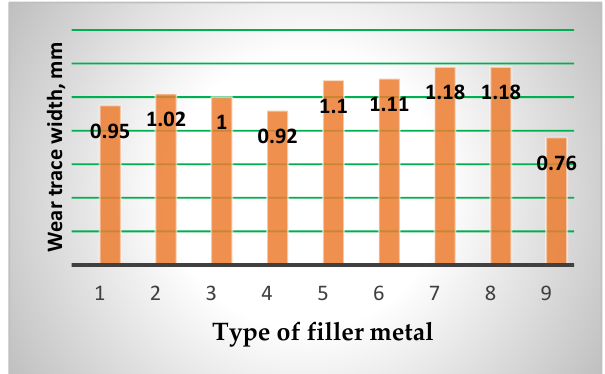
Figure 18. Comparison of the wear traces values for various filler metals (Numbers correspond to notation of Table 7).